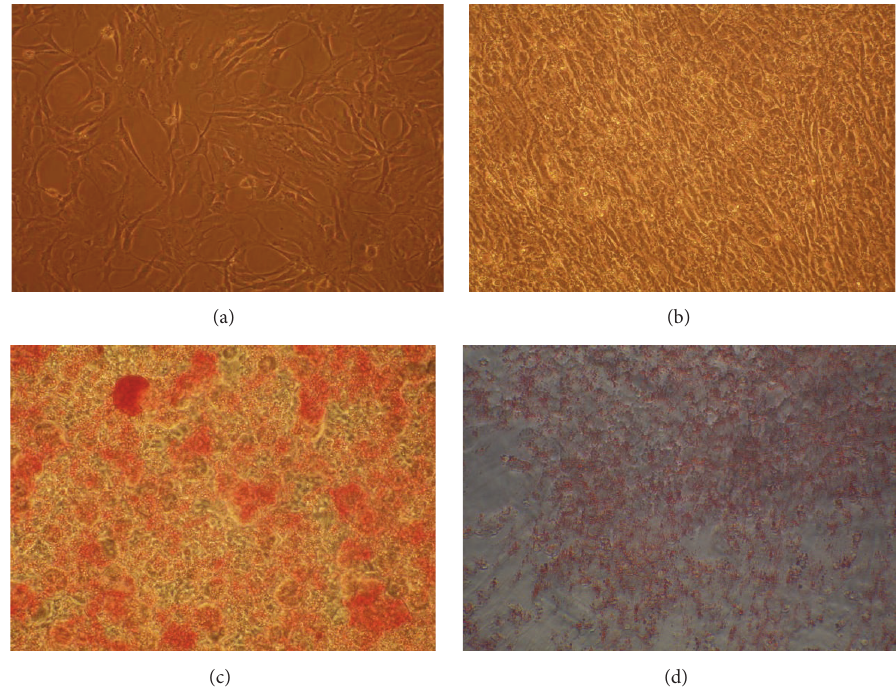
Figure 1: Different stages of cell growth. Figure 1 illustrates various growth stages of 3T3-L1 cell lines. (a) is the subconfluent cell stage; it is the nonadherent cell stage. (b) is confluent cell stage; it illustrates the adhesion of all cells in a culture disk. (c) is differentiated cell stage; it occurred when cells convert to specific cells. (d) is the inhibited cell stage; it comes when PL extract was poured on 3T3-L1 adipocytes during differentiated cell